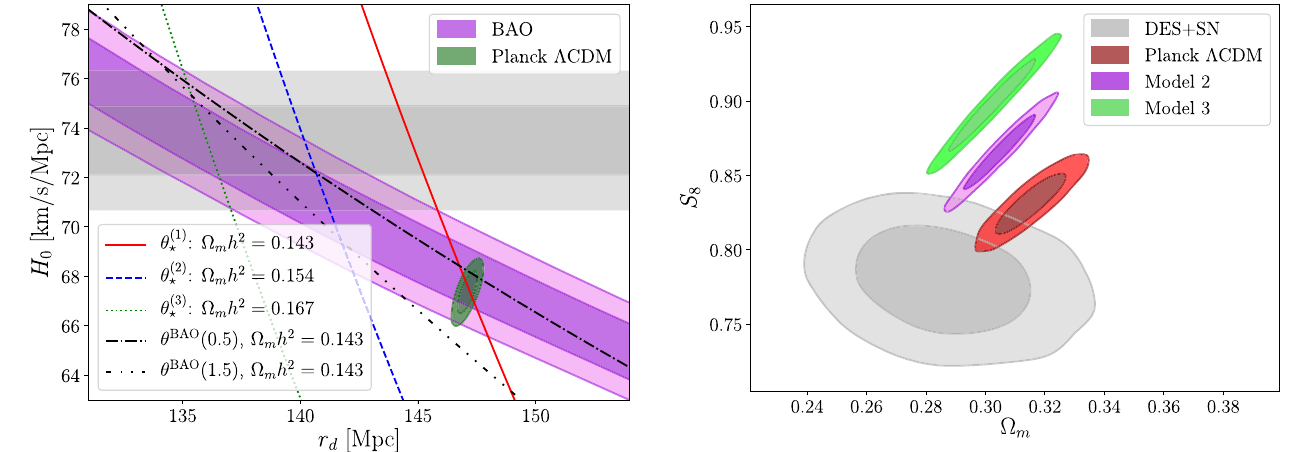
Fig. 2 The 68% and 95% con fi dence level bounds on S 8 and Ω m . Shown are the constraints derived by fi tting the Λ CDM model to a joint dataset of Dark Energy Survey (DES) and supernovae (SN) and to Planck, along with the contours for Model 2 and Model 3. Model 2 is de fi ned by the simultaneous fi t to baryonic acoustic oscillations (BAO) and cosmic microwave background (CMB) acoustic peaks at Ω m h 2 = 0.155, i.e., the overlap between the BAO band and the θ ð 2 Þ ? line in Fig. 1. Model 3 has Ω m h 2 = 0.167 and corresponds to the overlap region between the θ ð 3 Þ ? line and the BAO and SH0ES bands in Fig.